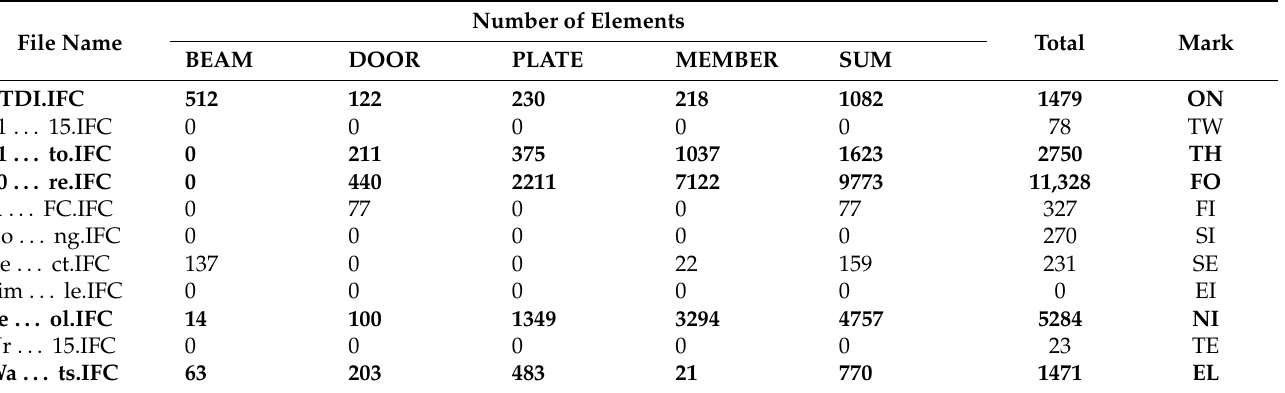
Table 3. Number of four elements extracted on the 11 IFC files.